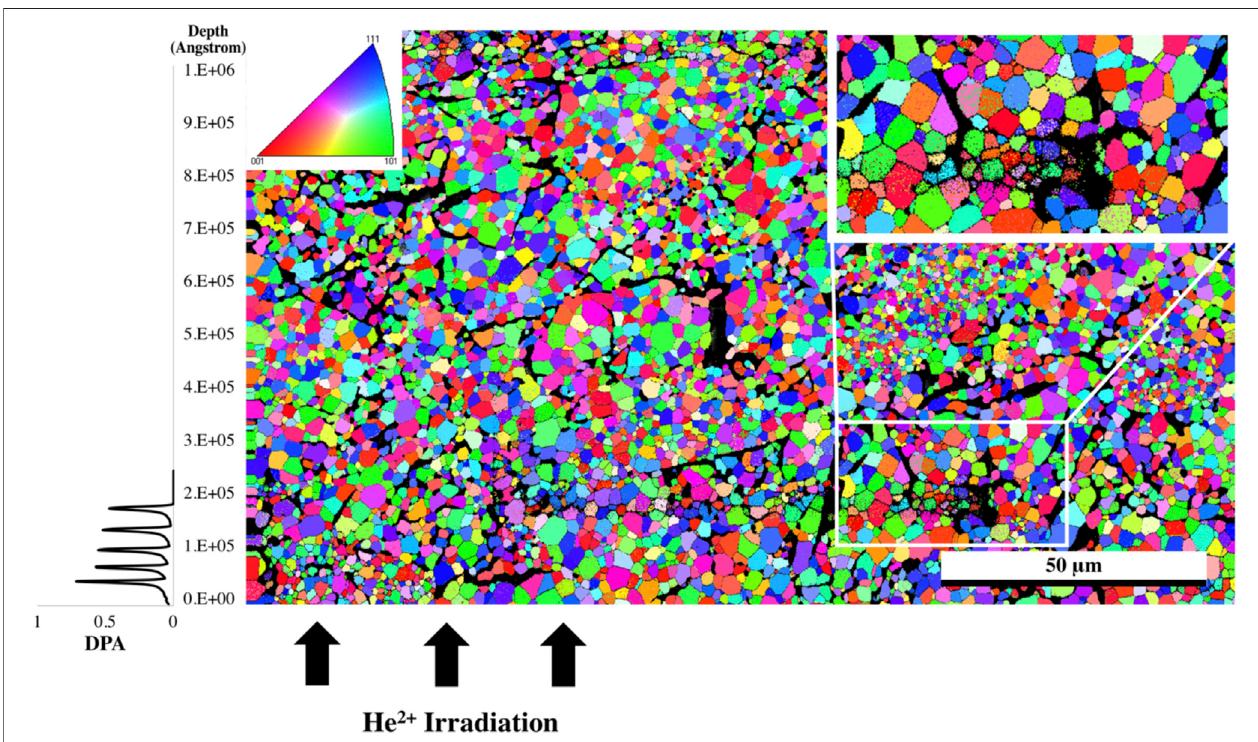
FIGURE5| EBSDgrainorientationmapoftheirradiatedNd 2 Zr 2 O 7 sampleutilizingthecifgeneratedfromneutrondiffractionassignedtotheundamagedpartofthe sample, direction of He 2+ ions are from the bottom of the image. The white rectangle indicates the area where the high-resolution EBSD was taken in Figure 6 , and the top left inset shows pole fi gure orientation. The plot to the left is the SRIM simulation and is provided as a comparison for penetration depth of the He 2+ ions.